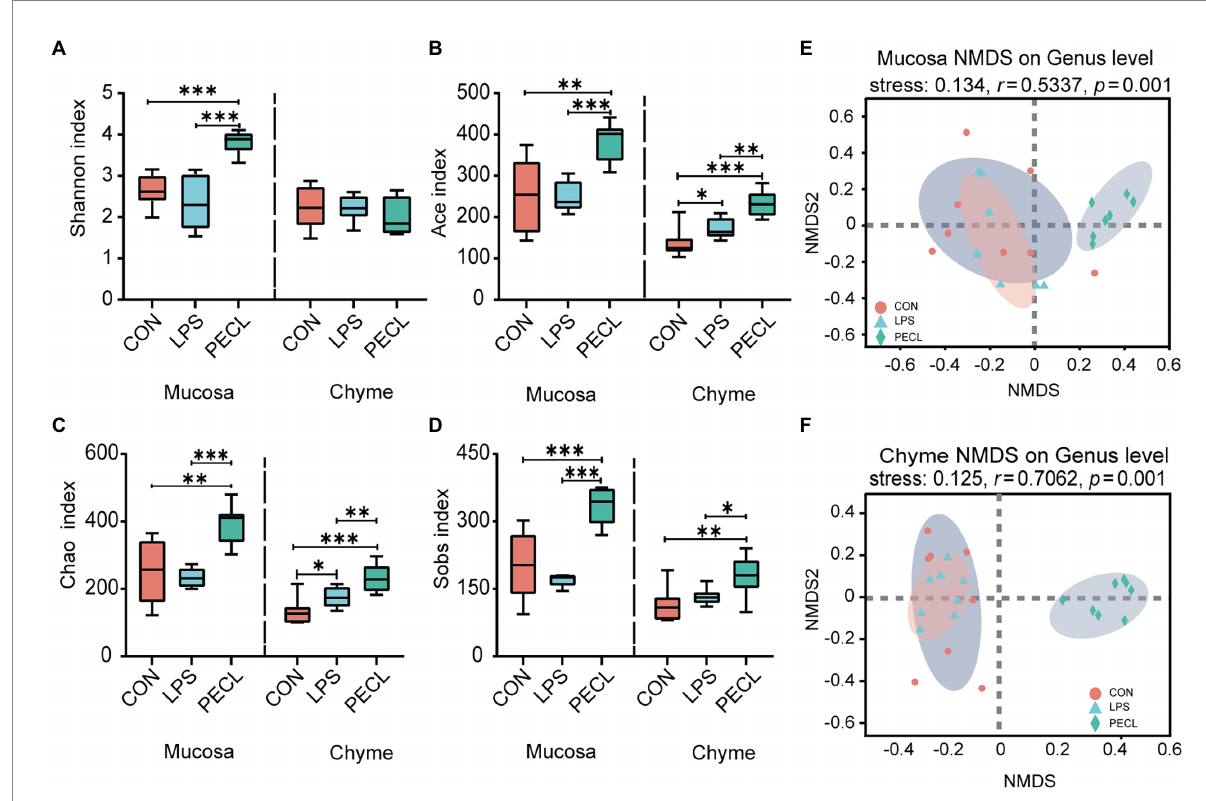
FIGURE 4 Structure and diversity of intestinal microflora of piglets in different groups. The alpha diversity indices observed species, (A) Shannon, (B) Ace, (C) Chao, and (D) Sobs among the three groups. NMDS plot of the chyme microbiota (E) and mucosa microbiota (F) based on weighted UniFrac